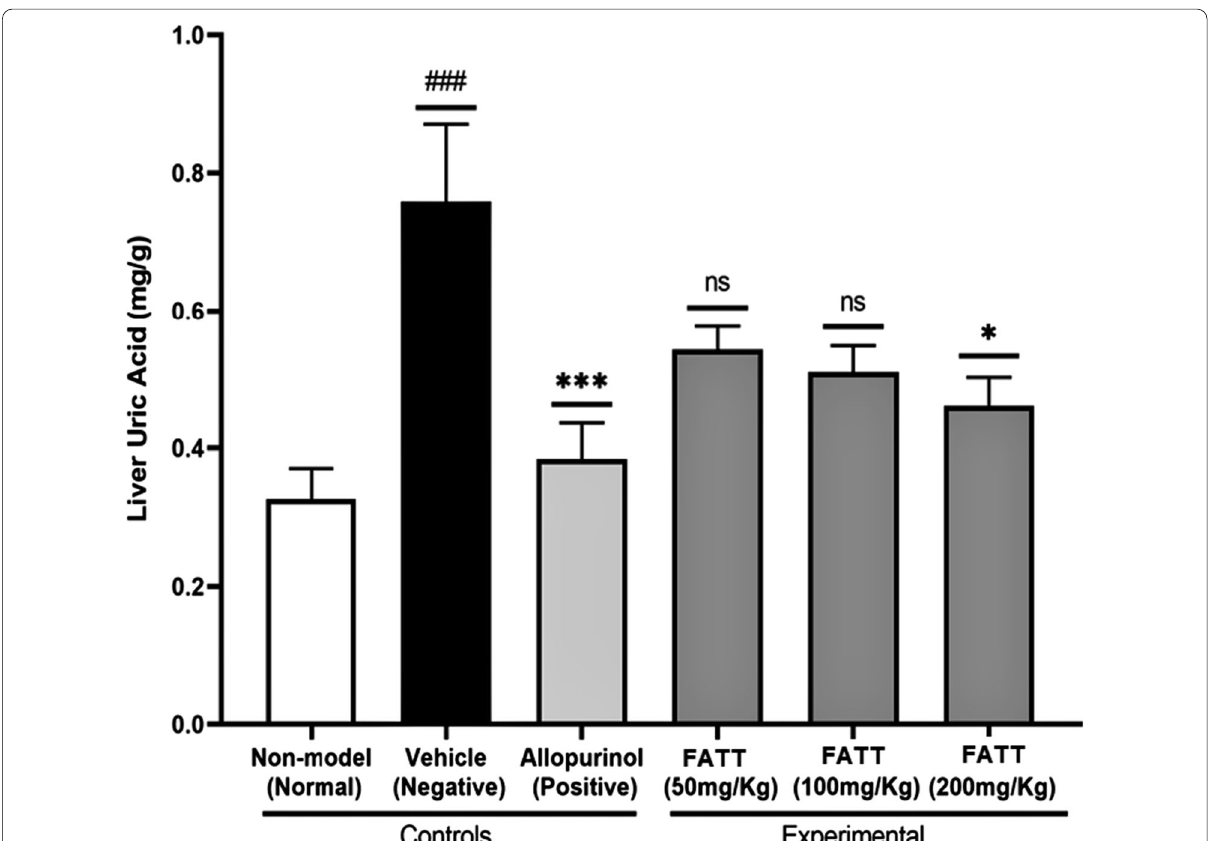
Fig. 4 One-way ANOVA (with Tukey’s post hoc) comparison of liver uric acid (LUA) levels of experimental (FATT-treated) and control mice groups. Data are presented as mean SEM ( n 8); LUA levels of the negative and normal controls were compared to ensure LUA elevation before ± = treatment; LUA levels of each of FATT-treated and negative control groups were compared to evaluate FATT’s LUA lowering effects. There was